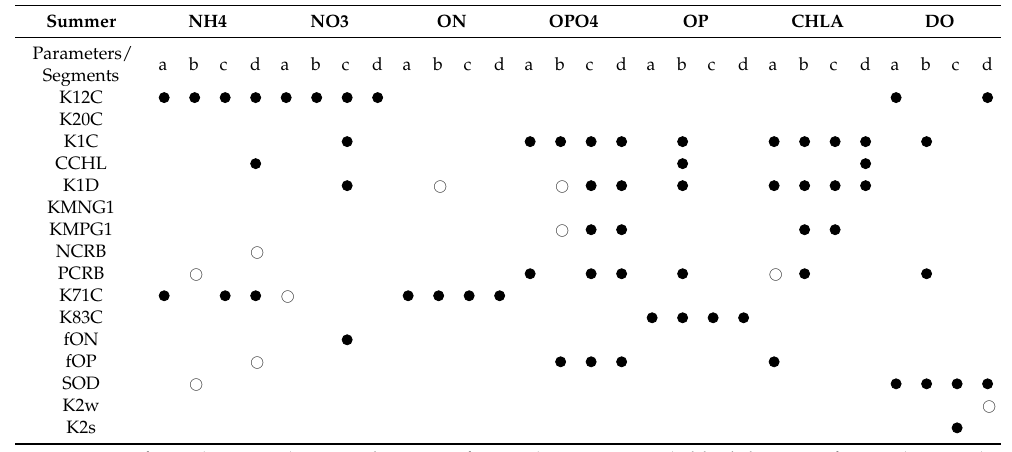
Table 3. Sensitivity analysis in summer.